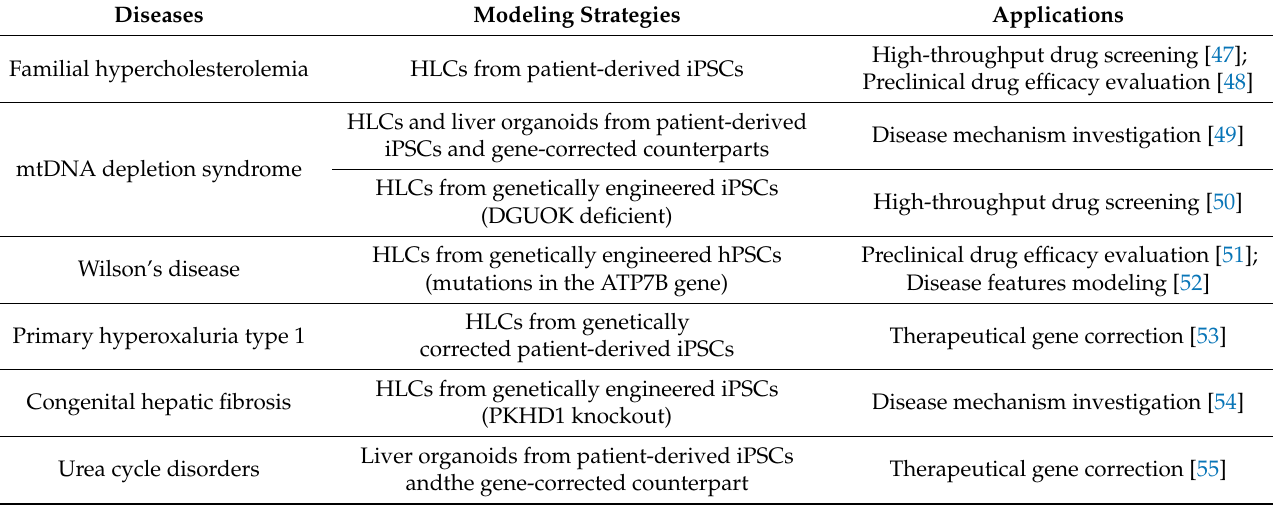
Table 2. Summary of hPSC-derived liver disease